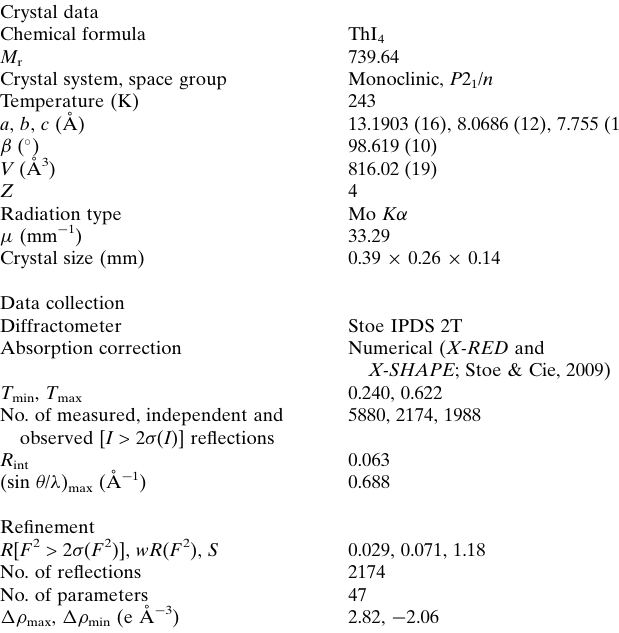
Crystal data Chemical